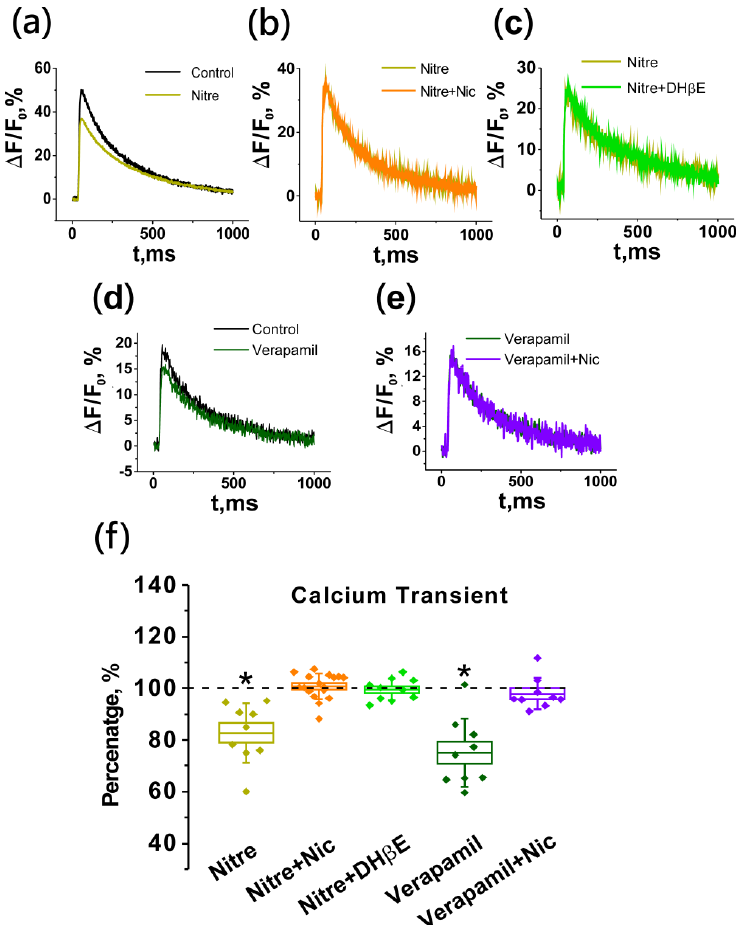
Figure 6. Lack of effect of nicotine (an increase in the amplitude of the calcium transient) and DH β E (a decrease in the amplitude of the calcium transient) after blockade of the Ca v 1 channels. Panels on the top are representative traces of calcium transient from individual experiments: ( a ) effect of Ca v 1 calcium channel blocker nitrendipine (Nitre, 25 µ M), ( b ) lack of nicotine (Nic, 10 µ M) effect after pre-application of nitrendipine, ( c ) lack of DH β E (1 µ M) effect after nitrendipine